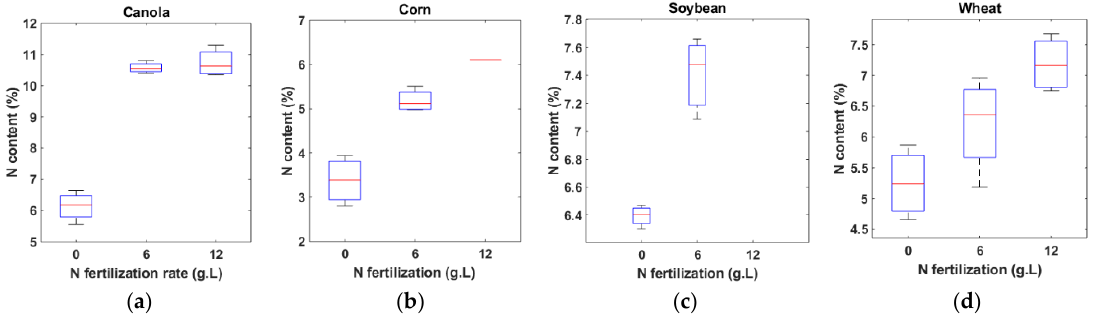
Figure 5. Boxplot of leaf N content of ( a ) canola, ( b ) corn, ( c ) soybean, and ( d ) wheat. Here, the horizontal axis represents the rate of N fertilization in g∙L, and the vertical axis represents the N content.